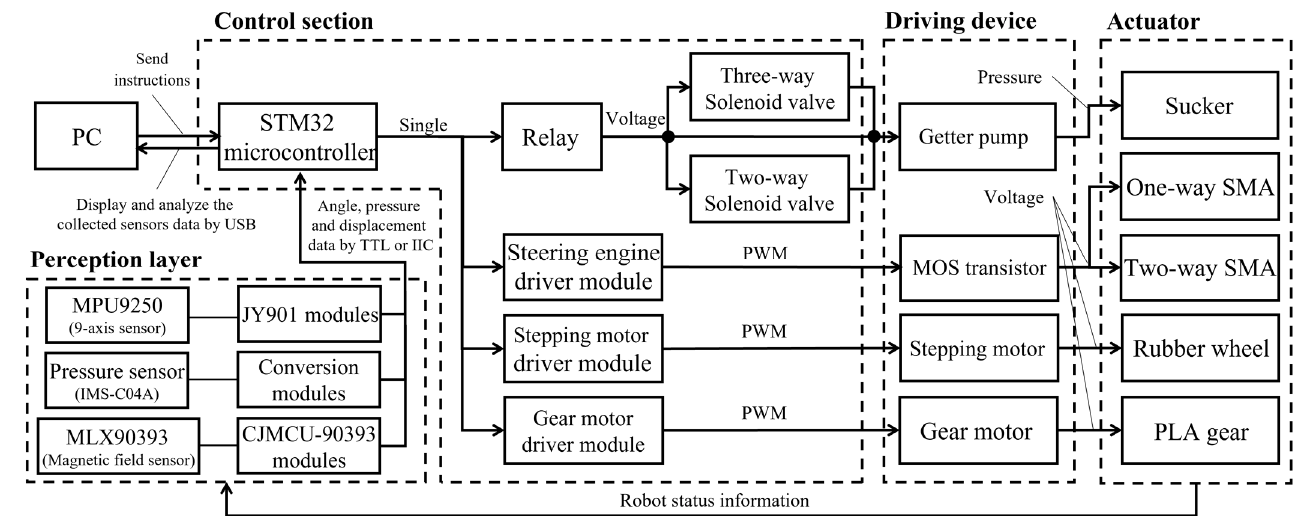
Figure 10. Control system hierarchy of the ISB-MWCR.